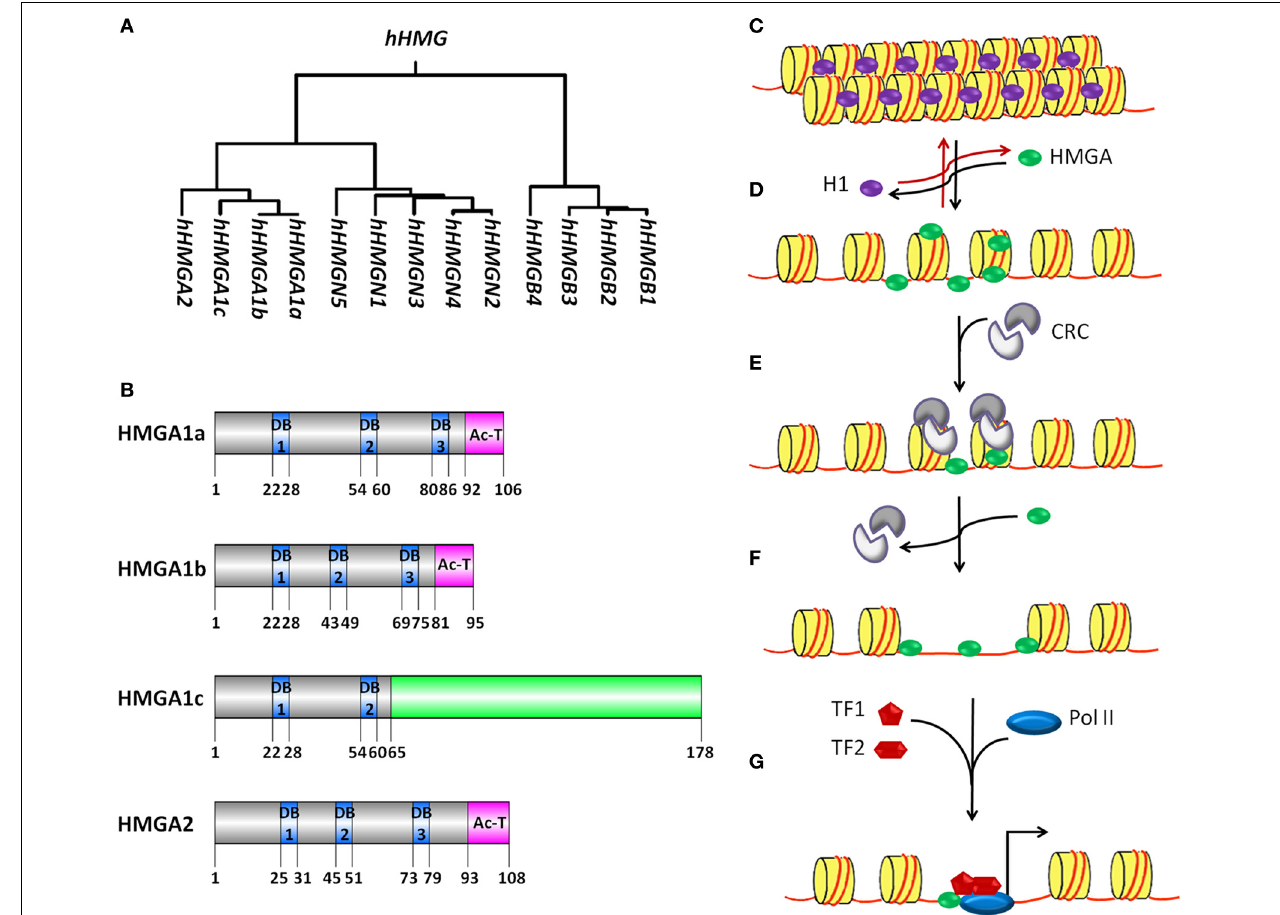
FIGURE 1 | The HMG proteins superfamily and model for HMGA proteins mediated transcription activation. (A) Genealogical tree of human HMG proteins. HMG proteins are divided into three families depending on their DNA binding domains: HMGA (containing AT-hooks), HMGB (containing HMG-boxes) and HMGN (containing nucleosomal binding domains). CLUSTALW software was used to build rooted genealogical tree with branch length (UPGMA) of human HMG group family members. (B) Schematic representation of human HMGA proteins. HMGA1a, HMGA1b, HMGA1c, and HMGA2 proteins contain unique DNA binding domains (DB, blue boxes) with a characteristic AT-hook motif and a C terminal acidic domain (pink boxes). HMGA1a and HMGA1b proteins show high sequence similarity. HMGA1b lacks eleven amino acids before the second DB when compared to HMGA1a and 1c. The amino acid sequence of HMGA1c differs from the one from HGMA1a and 1b starting from amino acid 65 (green box). GPS DOG 2.0 software was used to illustrate protein structure domains (Ren et al., 2009). (C–G) A model for the putative mechanism of HMGA proteins as